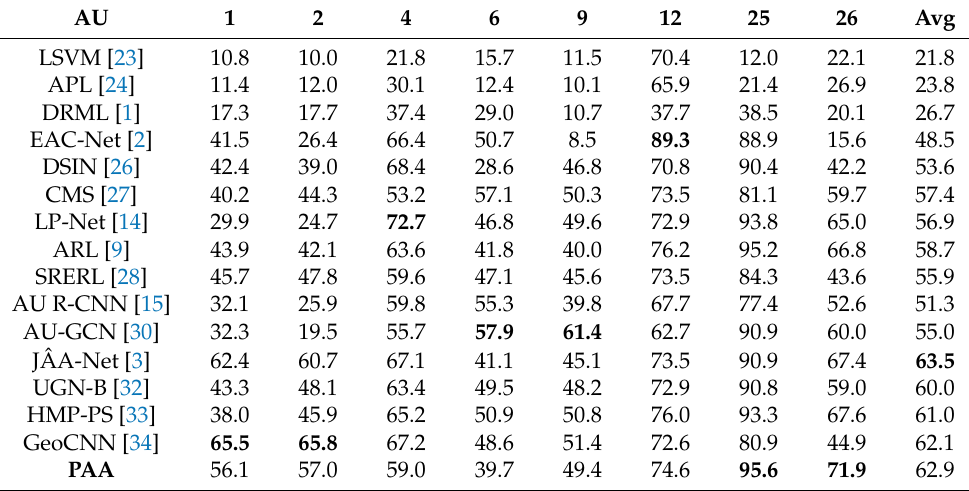
Table 2. F1-frame results on Denver Intensity of Spontaneous Facial Action (DISFA) [19]. The results of LSVM [23] and APL [24] are from [1], and those of other previous methods are reported in their original papers. The best results of each AU, as well as the average across methods, are shown in bold. Our PAA method achieves competitive performance, and achieves a more stable performance among different AUs than most of the previous works.